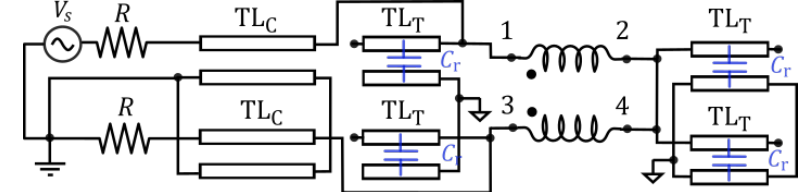
Figure 5. Equivalent circuit of the UDM setup for a CMC mounted on a PCB with an ungrounded return plane. Transmission lines labelled as TL C stand for the interconnecting cables. Transmission lines labelled as TL T represent the signal traces of the PCB. Since all the signal traces are terminated as open-circuits and they are supposed to be electrically short, they are actually modeled as capacitances C r to ground.